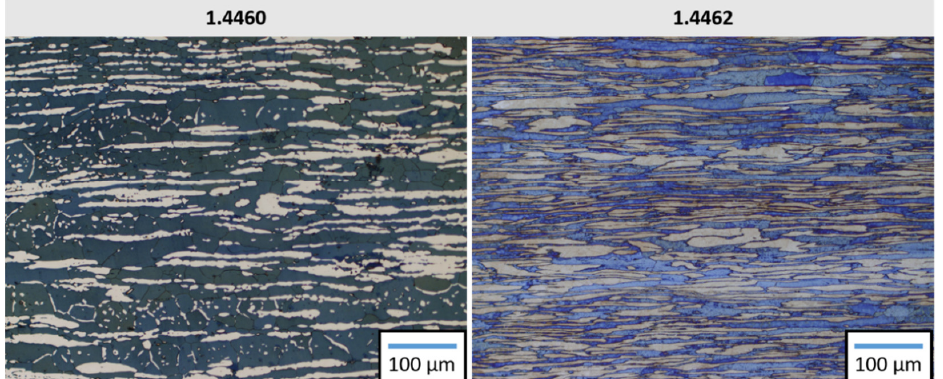
Figure 1. Micrographs from metallographical analysis on cross sections in the longitudinal direction for 1.4460 ( left ) and 1.4462 ( right ) etched with Beraha II etchant. The bright areas correspond to the austenite phase.